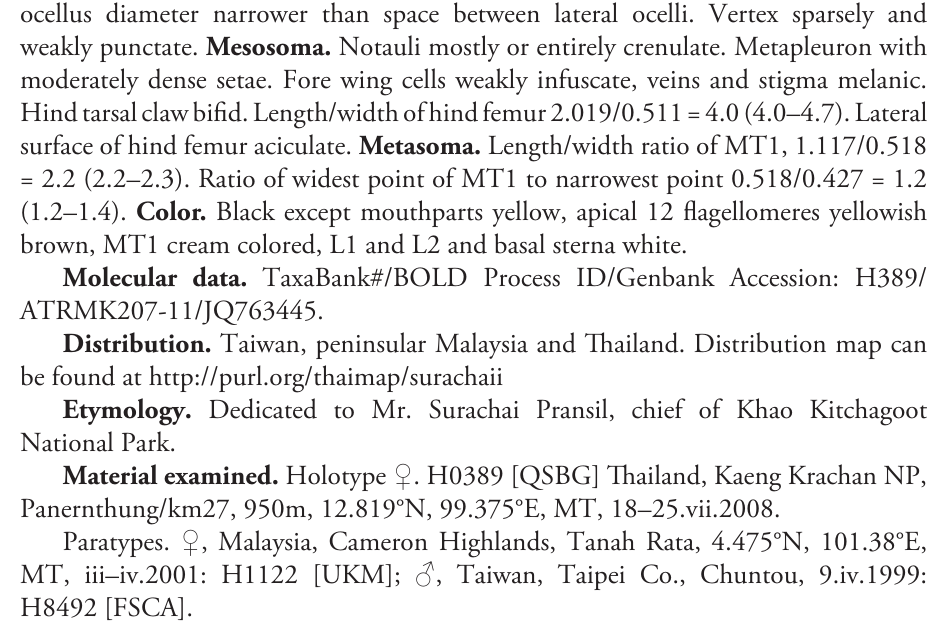
Diagnosis. Mesoscutum entirely melanic; hind tibia all melanic; head (not including mouthparts or antenna) melanic; apex of flagellum pale, contrasting with melanic base. Median tergite 1 white or cream colored. ocellus diameter narrower than space between lateral ocelli. Vertex sparsely and weakly punctate. Mesosoma. Notauli mostly or entirely crenulate. Metapleuron with moderately dense setae. Fore wing cells weakly infuscate, veins and stigma melanic. Hind tarsal claw bifid. Length/width of hind femur 2.019/0.511 = 4.0 (4.0–4.7). Lateral surface of hind femur aciculate. Metasoma. Length/width ratio of MT1, 1.117/0.518 = 2.2 (2.2–2.3). Ratio of widest point of MT1 to narrowest point 0.518/0.427 = 1.2 brown, MT1 cream colored, L1 and L2 and basal sterna